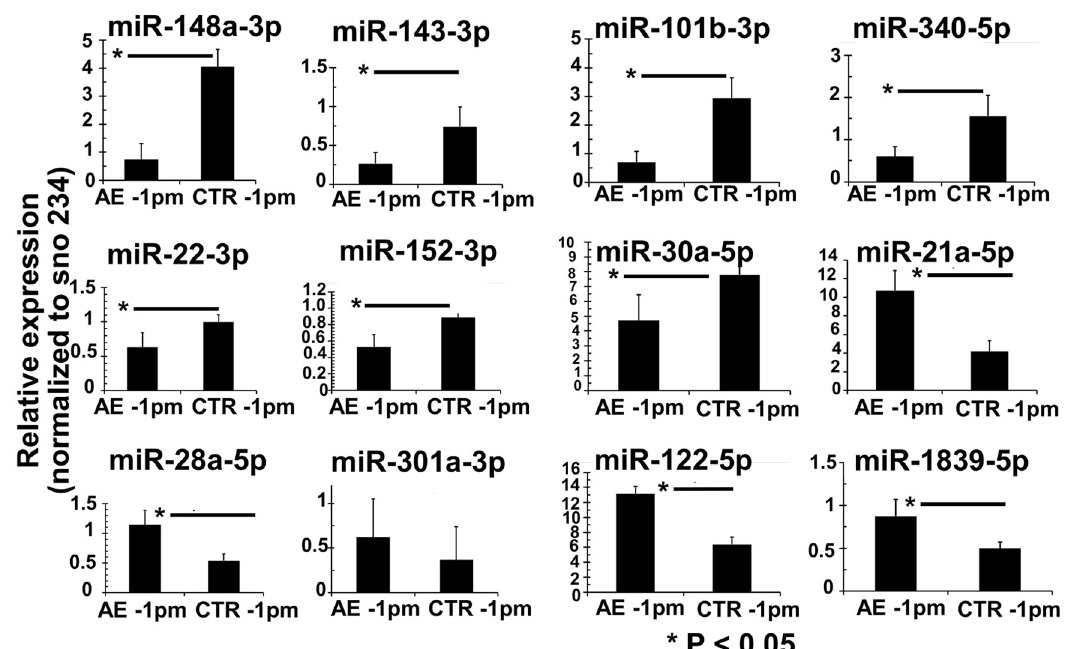
Fig 4. miRNAs expression validation by stem-loop RT-qPCR. Relative miRNA expression levels in livers of AE-infected and uninfected control mice. Normalization was done using sno234 as the endogenous control. Bars represent median ± standard deviation. All stem-loop RT-qPCRs for each miR used biological replicates (n = 5 infected group and n = 4 uninfected group), with three technical replicates per experiment.